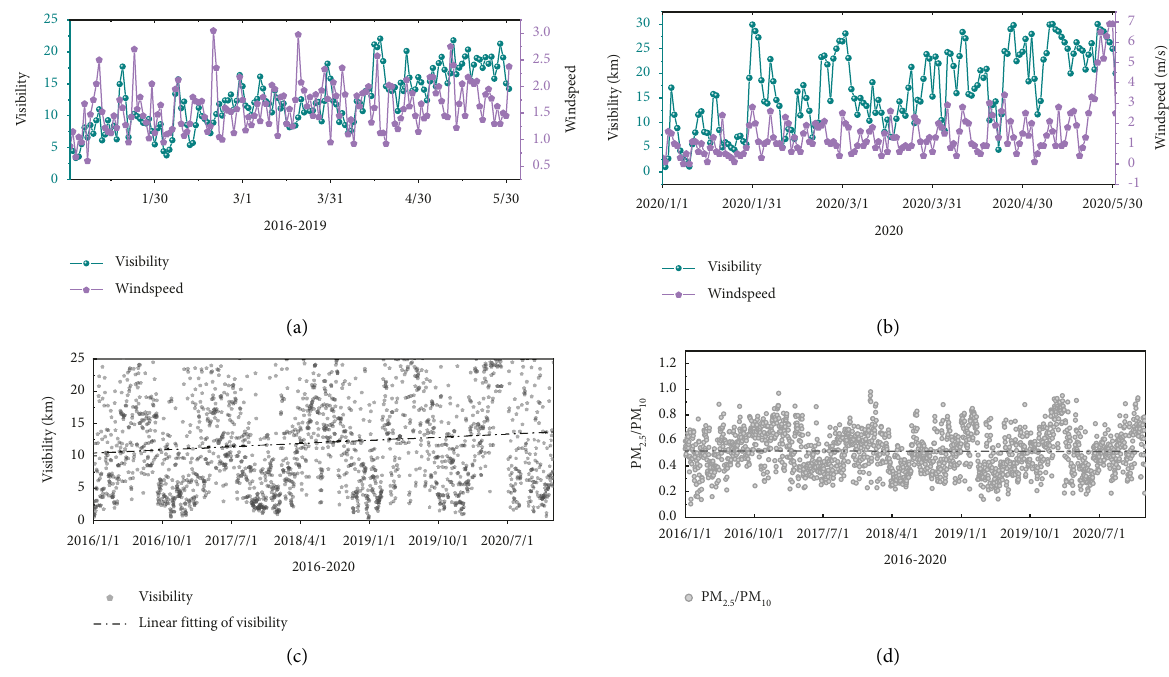
Figure 3: Visibility and wind speed trends from 2016 to 2019 and from January to May 2020 (a, b); visibility trend with time and PM ratio trend (c,